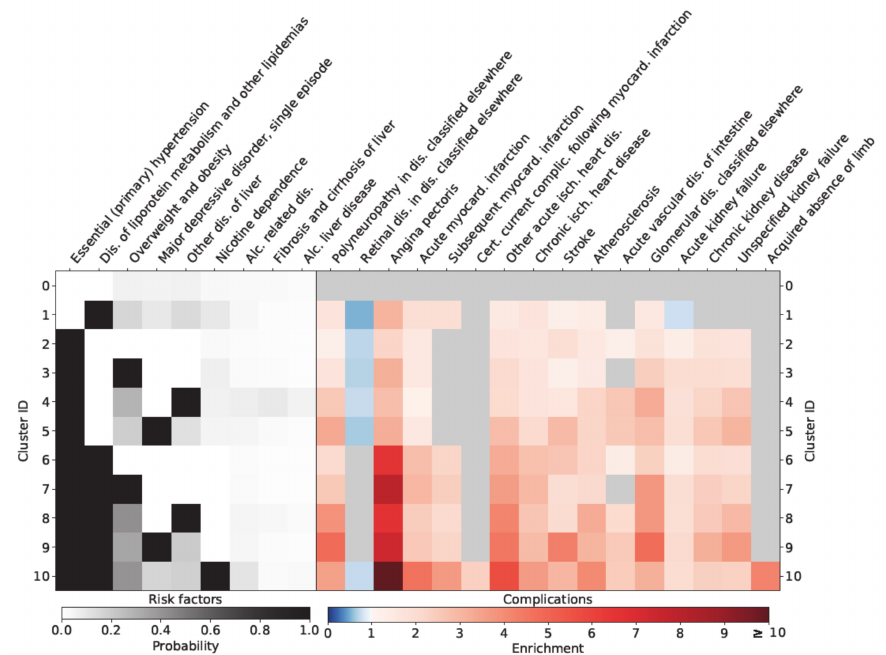
Figure 1. Relationship of different clusters with typical diabetes-specific